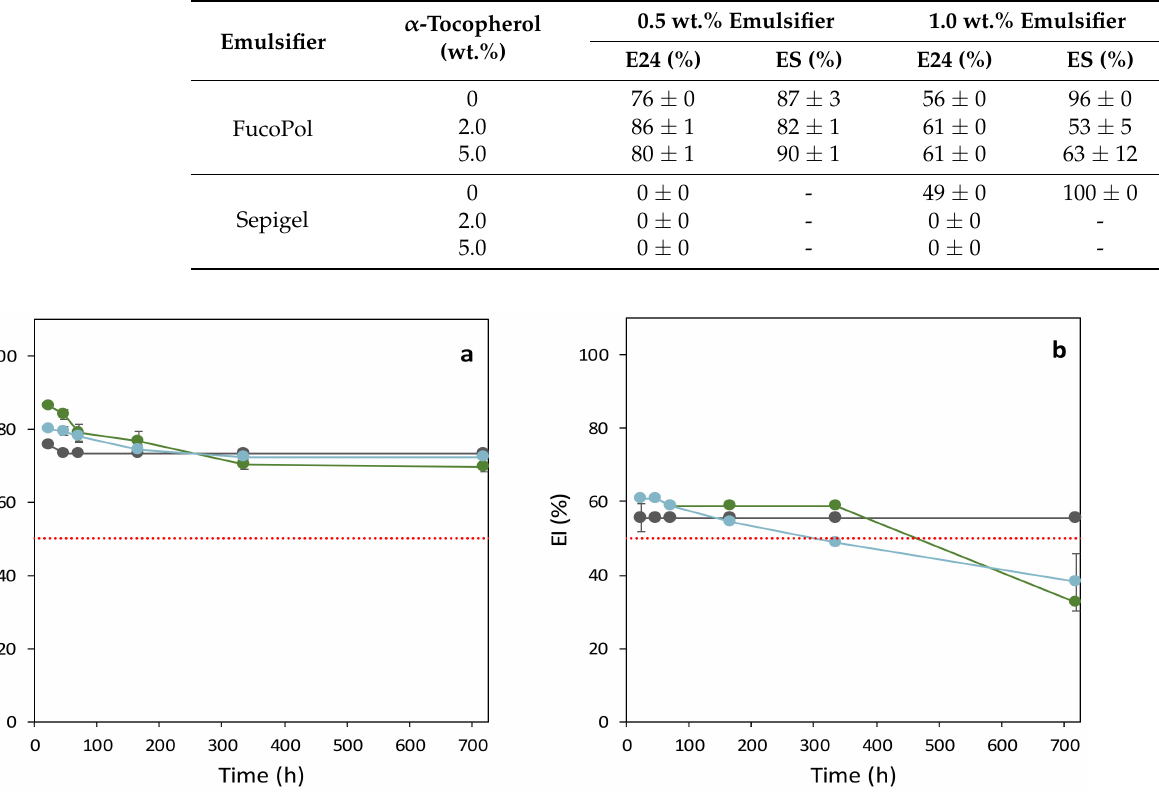
Figure 4. Emulsification index (EI%) over time for the FucoPol-stabilized emulsions with olive oil and α -tocopherol, at the 3:2 ratio: FucoPol (0.5 wt.% ( a ); 1.0 wt.%, ( b )); α -tocopherol: 0 wt.%, gray; 2.0 wt.%, green; 5.0 wt.%, blue. The red dashed line represents EI = 50%. ( n =